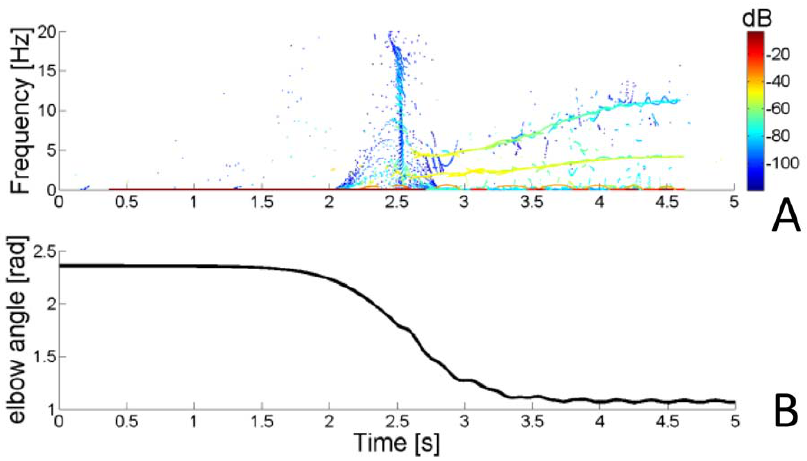
Figure 6. Frequency separation. A) Reassigned spectrogram of a perturbed movement. This panel illustrates the effect of an impulsive perturbation on the spectrogram of the elbow angular rotation, the frequency of the oscillations excited by the impulse are clearly identifiable. B) Time signal of the elbow rotation corresponding to the reassigned spectrogram in A). doi:10.1371/journal.pone.0033086.g006 PLoS ONE |